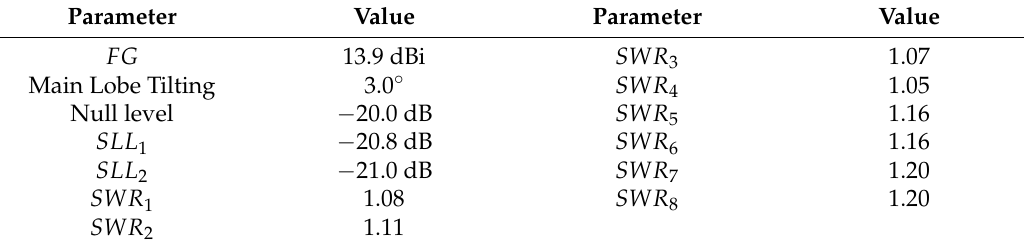
Table 4. Optimized structure electromagnetic characteristics.